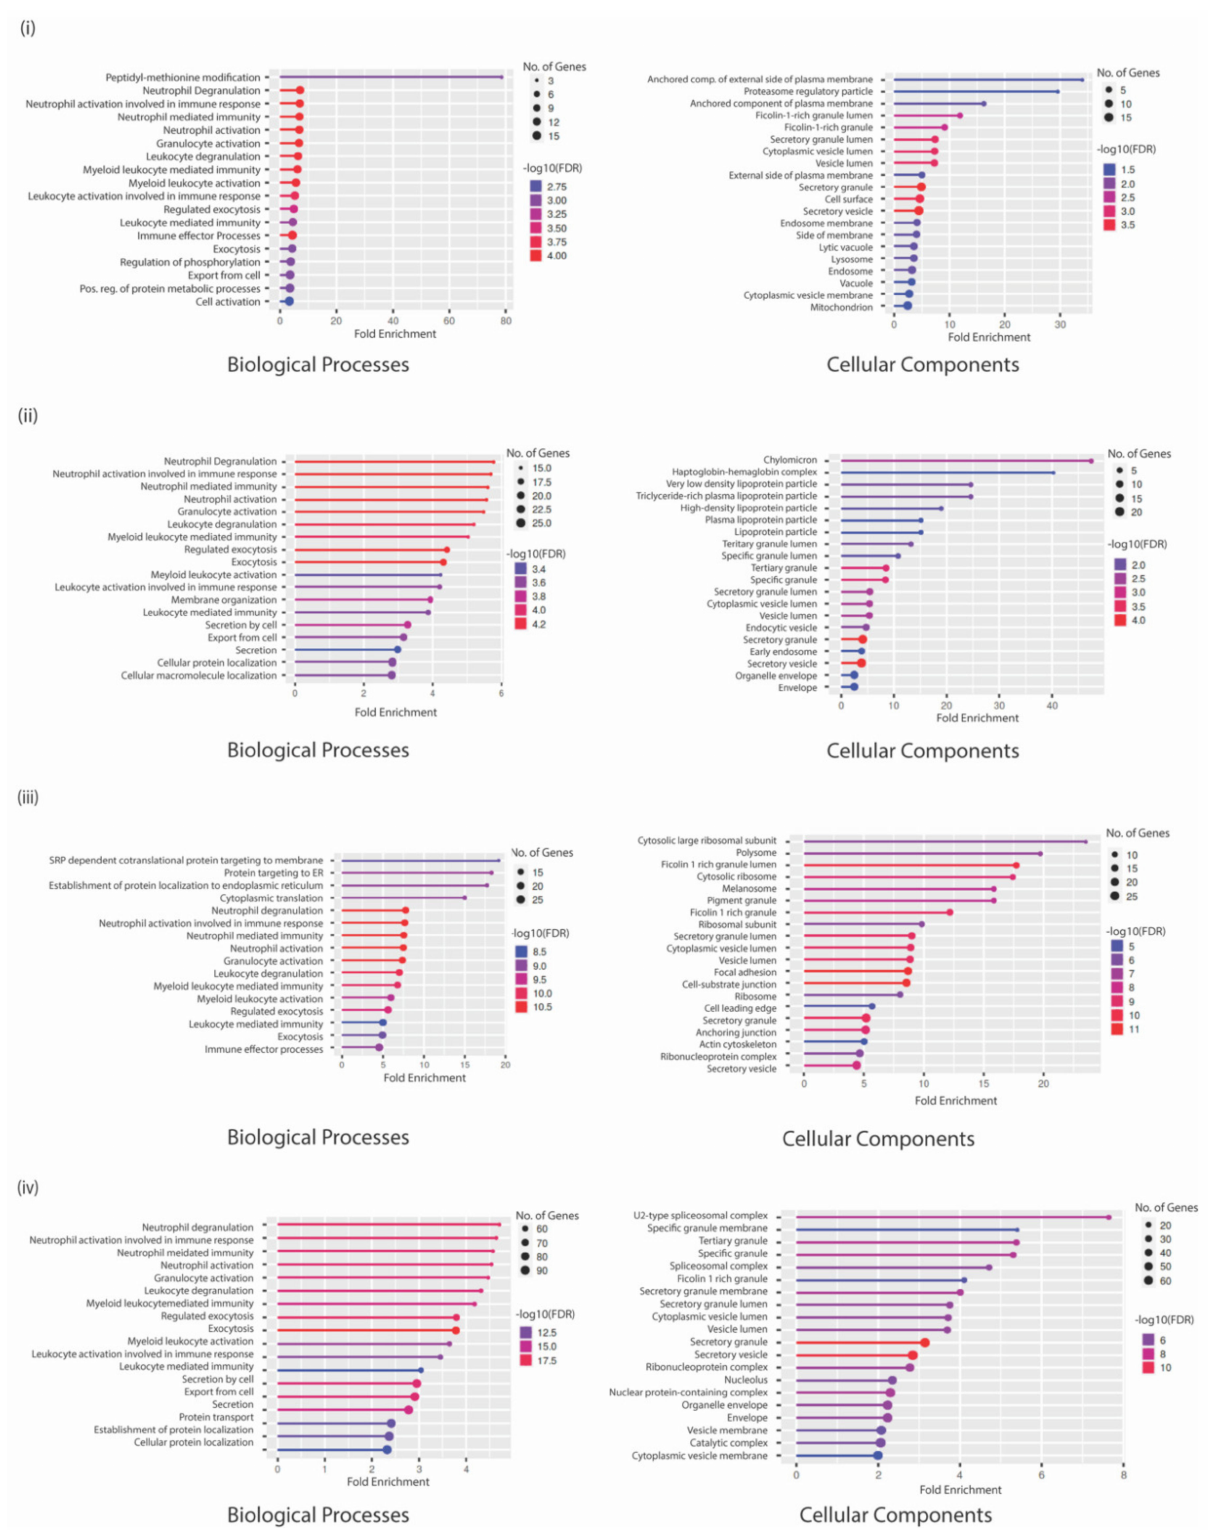
Figure 3. Gene-ontology analysis representing biological processes and cellular components in gene sets that are ( i ) upregulated in CTC low attachment culture conditions; ( ii ) downregulated in CTC low attachment culture conditions; ( iii ) upregulated in co-culture conditions with naïve neutrophils; and ( iv ) downregulated in co-culture conditions with naïve neutrophils. The thickness of the circles represents the number of genes in the cluster while the color of lines represents the FDR